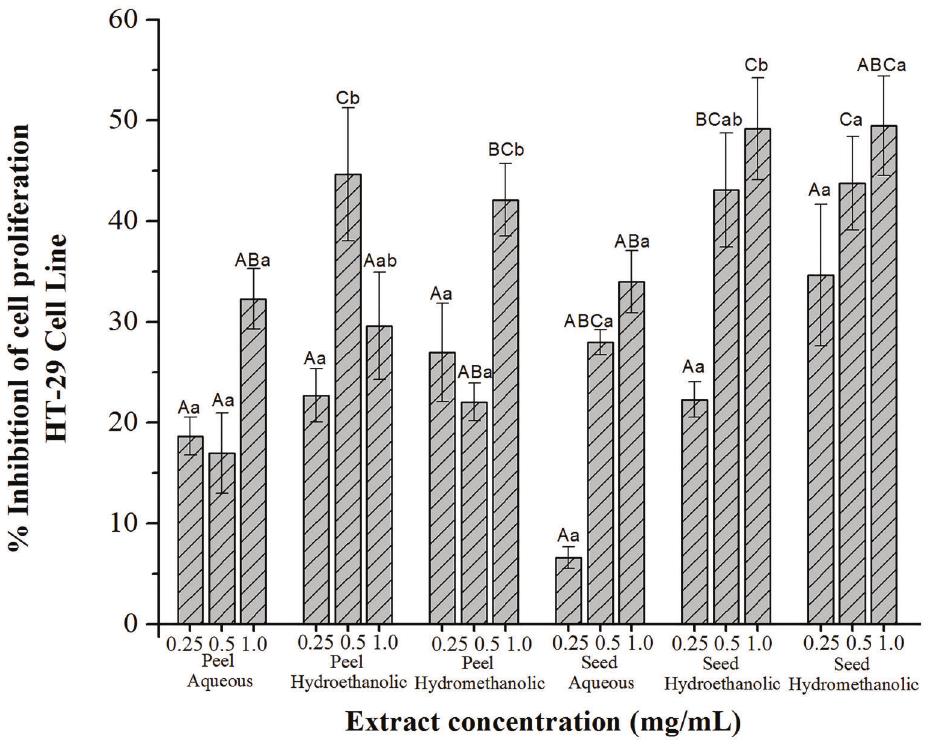
Figure 7. Effect of melon residues extracts on the inhibition of cell proliferation of the HT-29 cell line, measured by MTT test. Cells proliferation was carry out in the presence of melon residues extracts in different concentrations for 24 h. a,b,c,d Signi fi cant differences between different concentrations of the same sample. A,B,C,D Signi fi cant differences between different extracts in the same concentration (P o 0.05, ANOVA). Data are reported as means ±